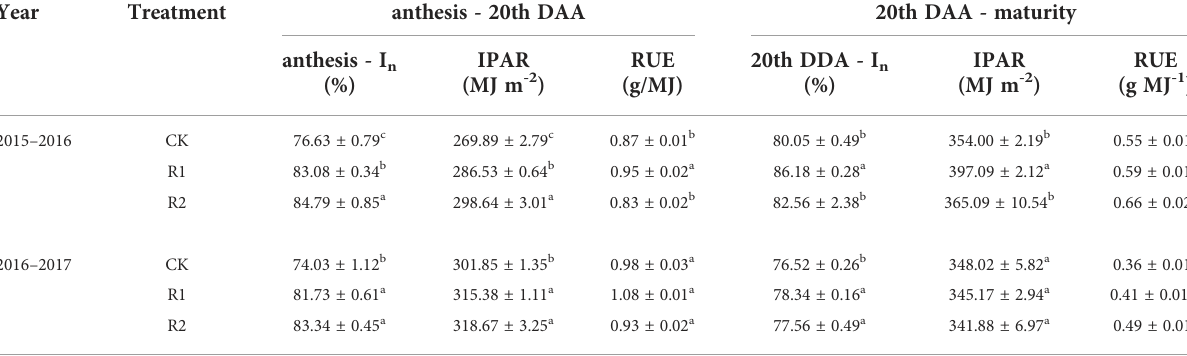
TABLE 3 PAR interception (IPAR), PAR interception ef fi ciency (I n ) and Radiation Use Ef fi ciency (RUE). Year